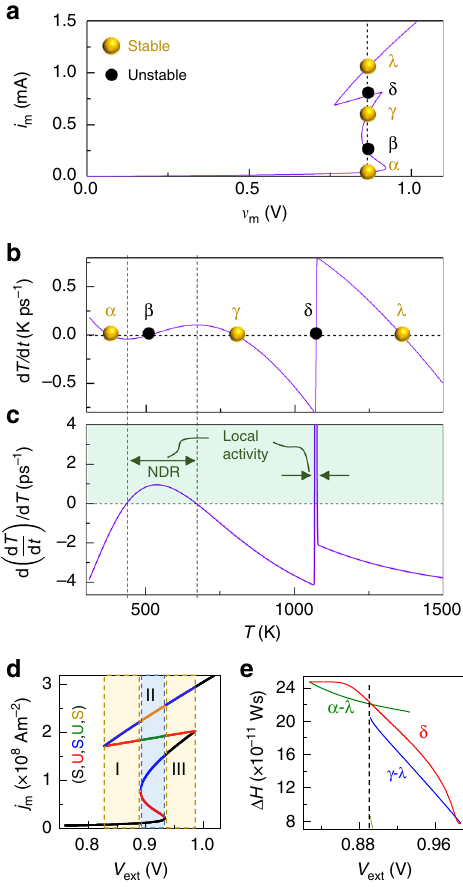
Fig. 5 Current-controlled and temperature-controlled instabilities representing NbO 2 . a i m – v m plot obtained by solving Eqs. (1) and (2) with a Mott transition at 1070 K described by R th . b The dynamical route map d T / d t vs. T for an applied external voltage of 0.91 V. Yellow and black spheres indicate stable and unstable steady-states, respectively. α – λ are steady- state points for an applied external voltage of 0.91 V. c d against T . Green shaded region indicates positive ordinate values where local activity exists. Temperature range of negative differential resistance (NDR) is also marked. d Stable ( ‘ S ’ ) and unstable ( ‘ U ’ ) current densities corresponding to the steady-states for different applied V ext , color coded with the legend. Dashed vertical lines separate regions I – III with different sets of steady-states. e Δ H plotted against V ext for the unstable state δ and two possible decomposed con fi gurations α – λ and γ – λ . Dashed black line indicates the voltage at which Δ H of γ − λ is lower than that of α – λ . Extended data shown in Supplementary Fig.